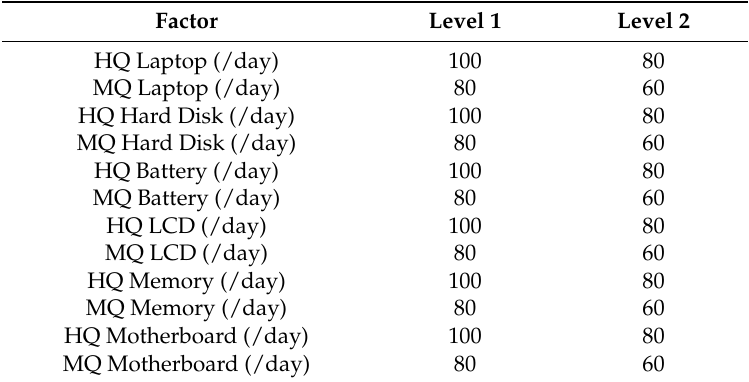
Table 8. Remanufactured laptop, subassembly, and component demands (following a Poisson distribution).